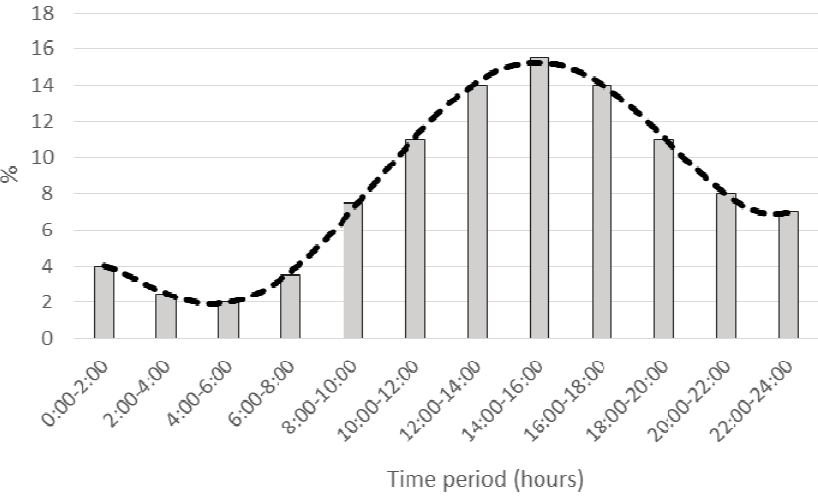
Figure 7. Average of hourly consumption of cold water for human consumption in the hospitals of the sample.